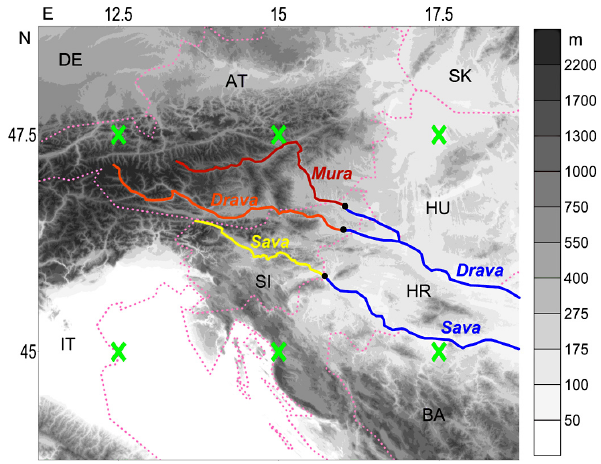
Fig. 1. The topography of the studied area. The studied parts of the rivers are distinguished by different colours; black dots represent the water gauges (see Table 1). Green crosses mark the centres of the studied pixels of the ERA-40 grids.